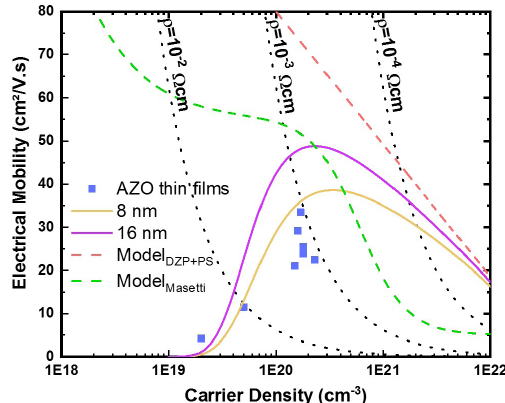
Figure 8. Experimental electrical mobility and theoretical mobility obtained by the DPZ+PS model 37 , and the Masetti model 38 , as a function of the carrier